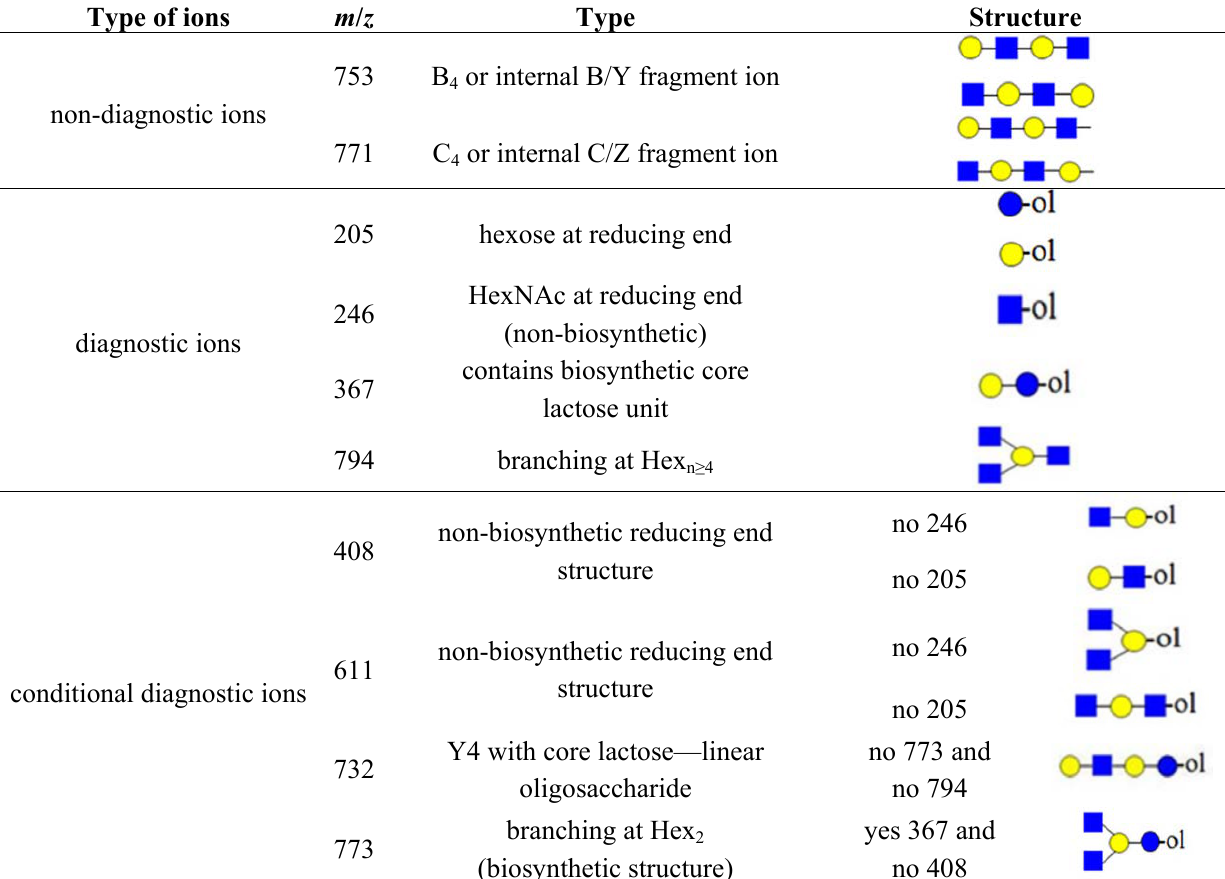
Table 1. Diagnostic and conditional diagnostic ions found and monosaccharide symbols used in this study. denotes N -acetylglucosamine, galactose and